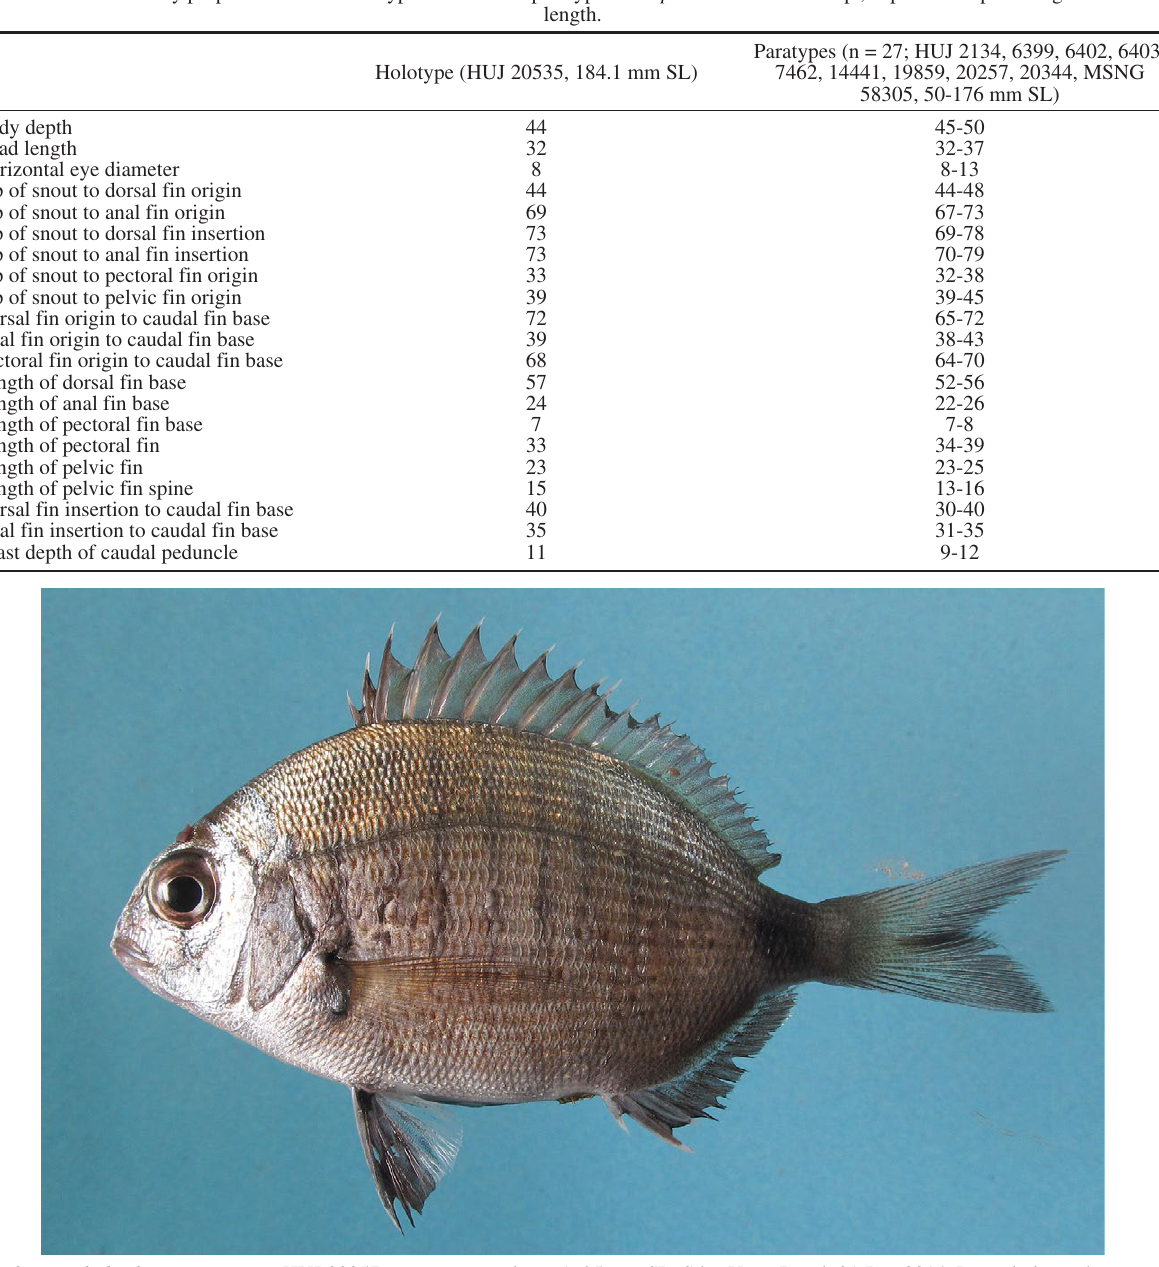
Fig. 2. – Diplodus levantinus n. sp., HUJ 20257, paratype, specimen 1, 95 mm SL, Sdor Yam, Israel, 21 Jan. 2014. Lateral view; photograph of the fresh colouration taken a few hours after collection (Photograph: D.